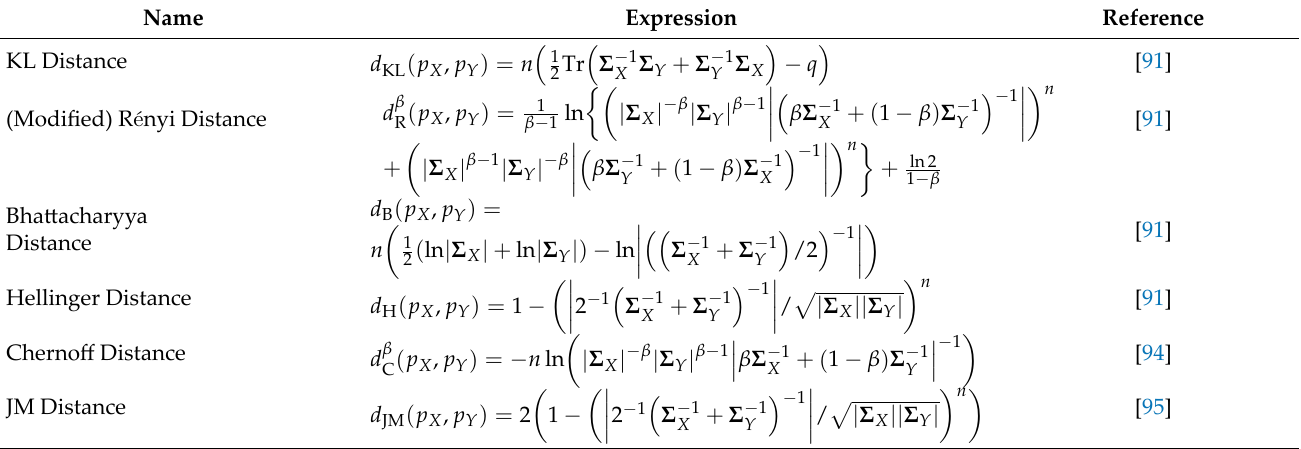
Table 6. Stochastic distances between complex Wishart